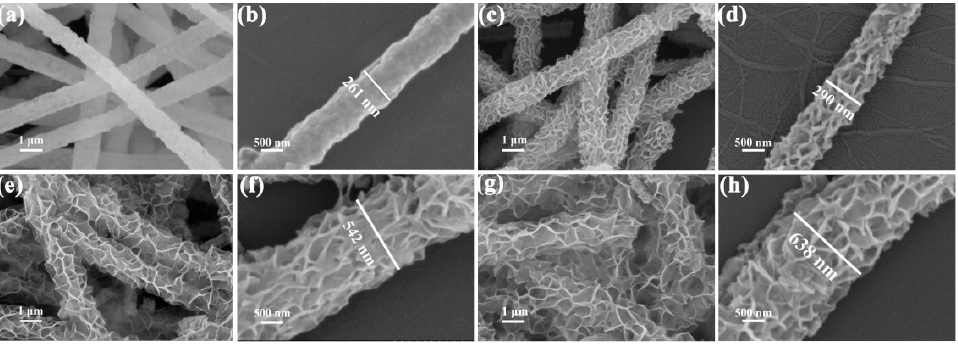
Figure 1. SEM images of ( a , b ) NMO, ( c , d ) NMH − 1, ( e , f ) NMH − 2, and ( g , h ) NMH − 3.